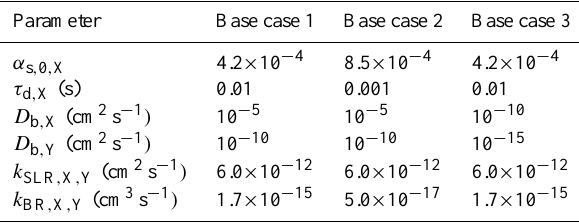
Table 1. Kinetic parameters for the interaction of ozone (X) and oleic acid (Y) in different model scenarios (base cases 1–3). Parameter Base case 1 Base case 2 Base case 3 α s , 0 ,